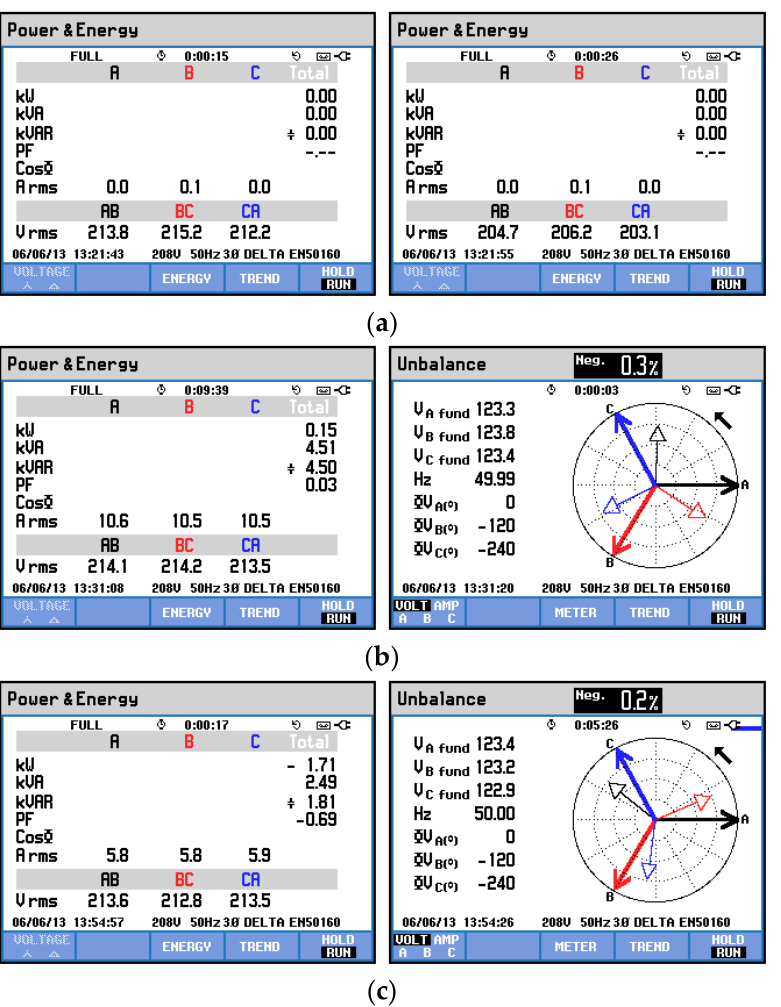
Figure 10. Voltage regulation in steady state: ( a ) nominal and reduced voltage without compensation, ( b ) reactive power compensation and ( c ) apparent power compensation.